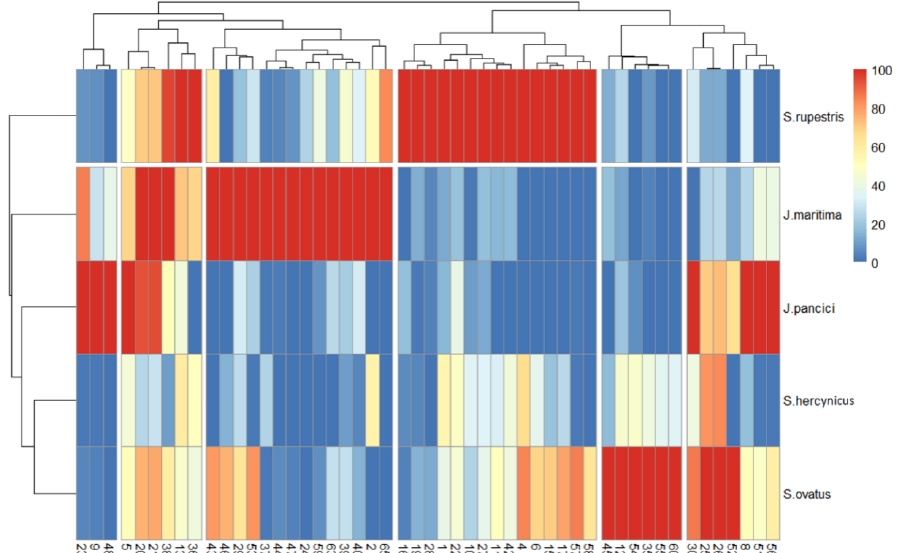
Figure 3. Heatmap of the normalized AUC values, from 0 (in case the compound was not detected) to 100, of the identified compounds (columns) by species (rows).